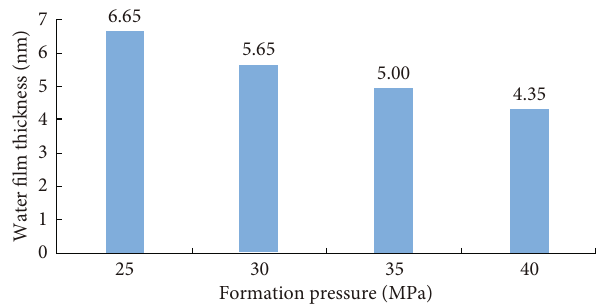
Figure 8: Histogram of the critical water fi lm thickness under di ff erent formation pressures of the Longfengshan